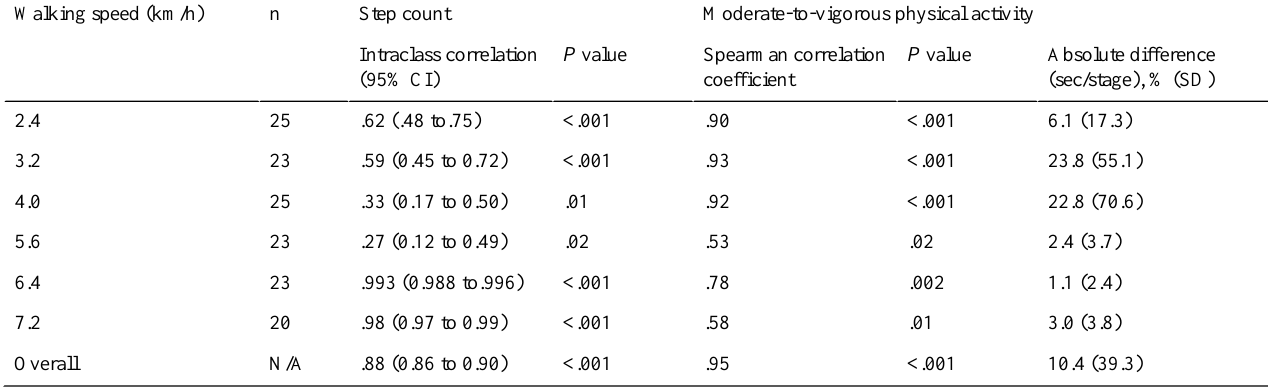
Table 5. Reliability of the PiezoRx in measuring step count and moderate-to-vigorous physical